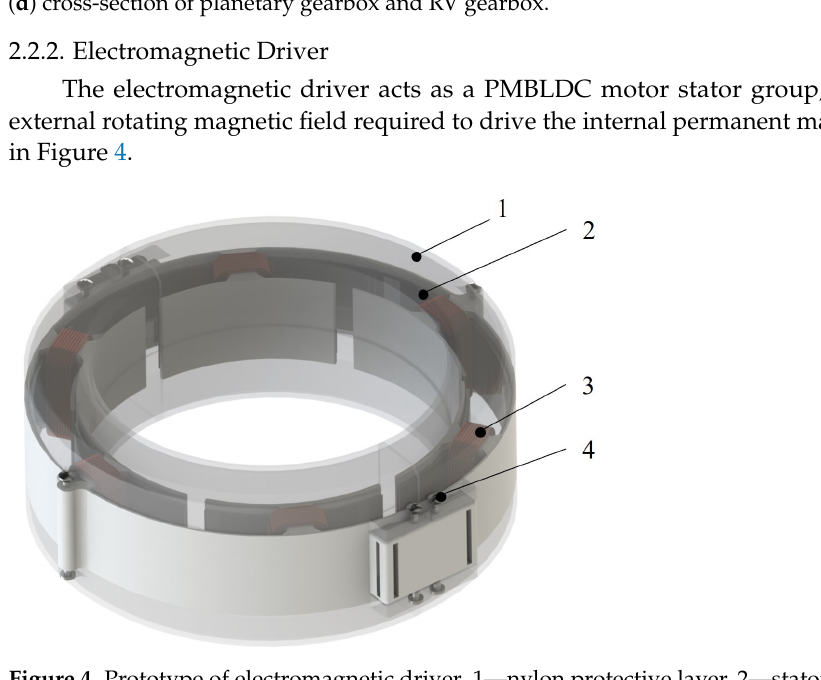
Figure 4. Prototype of electromagnetic driver. 1—nylon protective layer, 2—stator core, 3—copper wire, 4—self-tapping